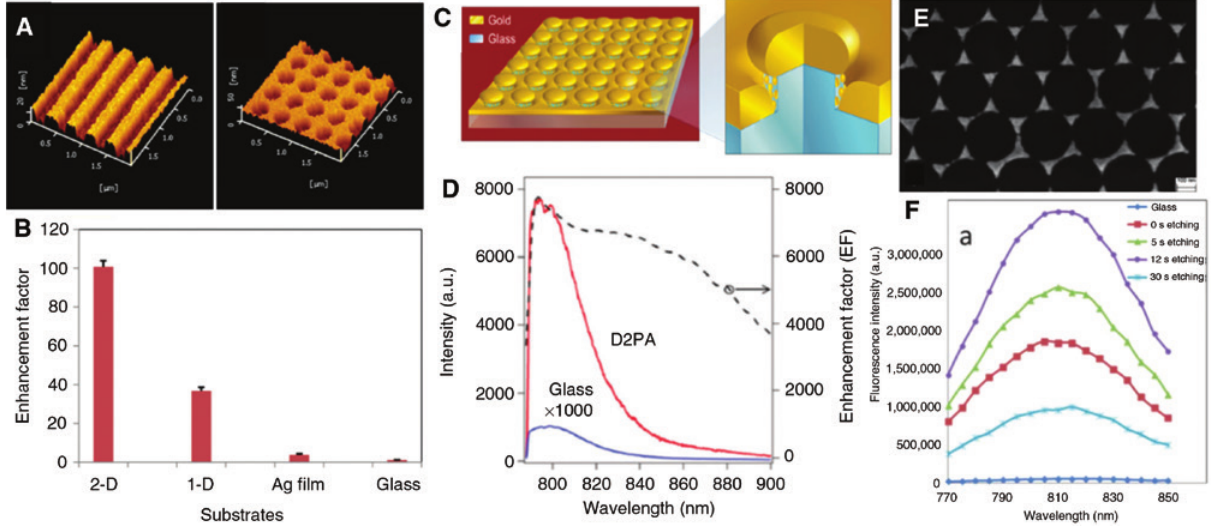
Figure 3: Metal-enhanced fluorescence on different nano-array structures. (A) Scanning probe microscopy images of 1D and 2D gratings after metal deposition. Grating pitch = 400 nm. (B) Enhancement factor (EF) of the fluorescence intensity on different substrates using plane glass as reference (EF = 1.0) (A and B adapted from Ref. [57] with permission from John Wiley and Sons). (C) Schematic (overview and cross section) of disk-coupled dots-on-pillar antenna array (D2PA) plate without an immunoassay. D2PA has an array of dense three-dimensional (3D) resonant cavity nano-antennas (formed by the gold disks on top of periodic nonmetallic pillars and the gold backplane on the pillar foot) with dense plasmonic nanodots inside and couples the metallic components through nanogaps. (D) Measured area average fluorescence intensity spectrum of the human-IgG labeled with IRDye800CW captured by the assay on the D2PA (red line) and the glass plate (blue line, which is amplified 1000 times to be visible at given scales), respectively. (C and D reprinted with permission from [58]; copyright (2012) American Chemical Society). (E) SEM images of Au nanostructure with 5s oxygen plasma etching. (F) Fluorescence spectra intensity change with etching time (E and F reproduced from Ref. [61] with permission from The Royal Society of